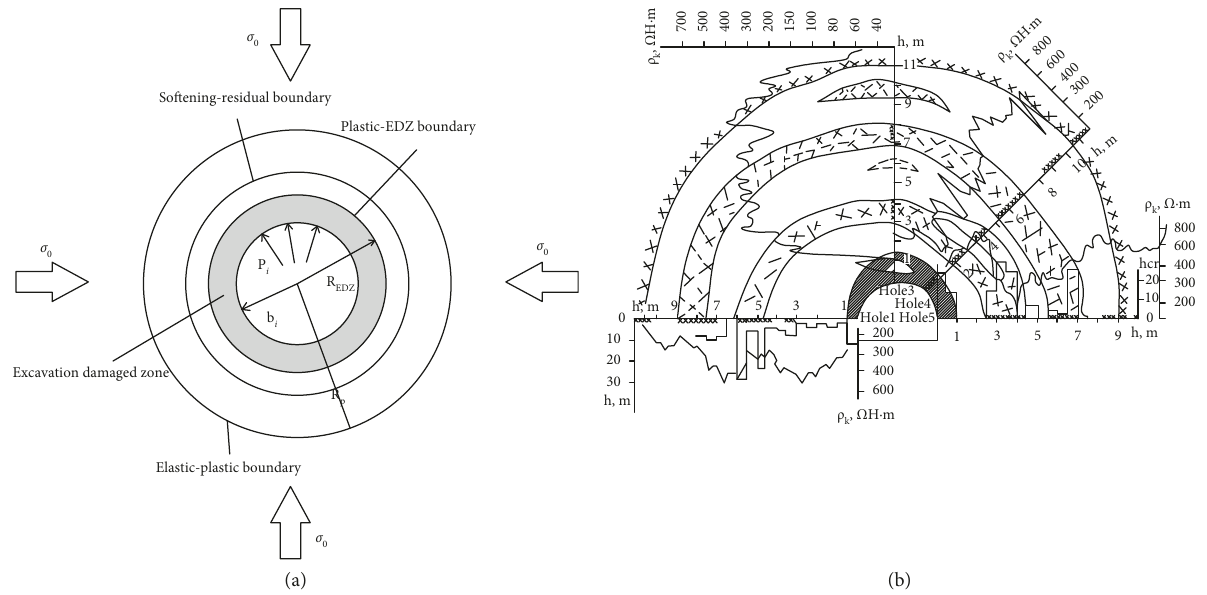
Figure 1: Fracture distribution around the tunnel: (a) based on elastic-plastic theory [1]; (b) field monitoring result